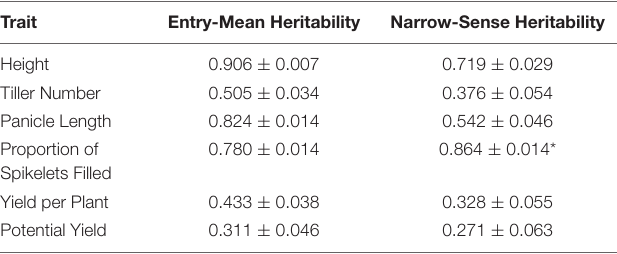
TABLE 2 | Estimates and their standard errors for each trait of entry-mean heritability of the F 1 hybrids and narrow-sense heritability on a single-plant basis. Trait